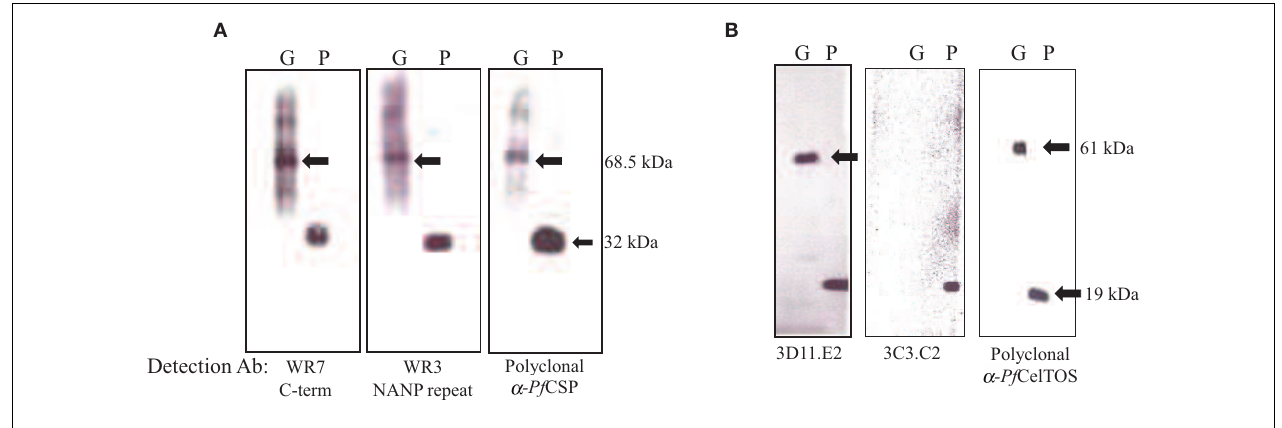
3D11.E2 = Pf CelTOS-specific, conformation-dependent mAb; 3C3.C2 = Pf CelTOS-specific, conformation-independent mAb; polyclonal = serum pool from rabbits immunized with recombinant Pf CelTOS/ISA 720. Arrows indicate fusion protein in molecular mass. G is GeMI-Vax lysate; P is recombinant protein. Molecular weight of the r Pf CSP is 34kDa and the r Pf CelTOS is 19.1kDa.